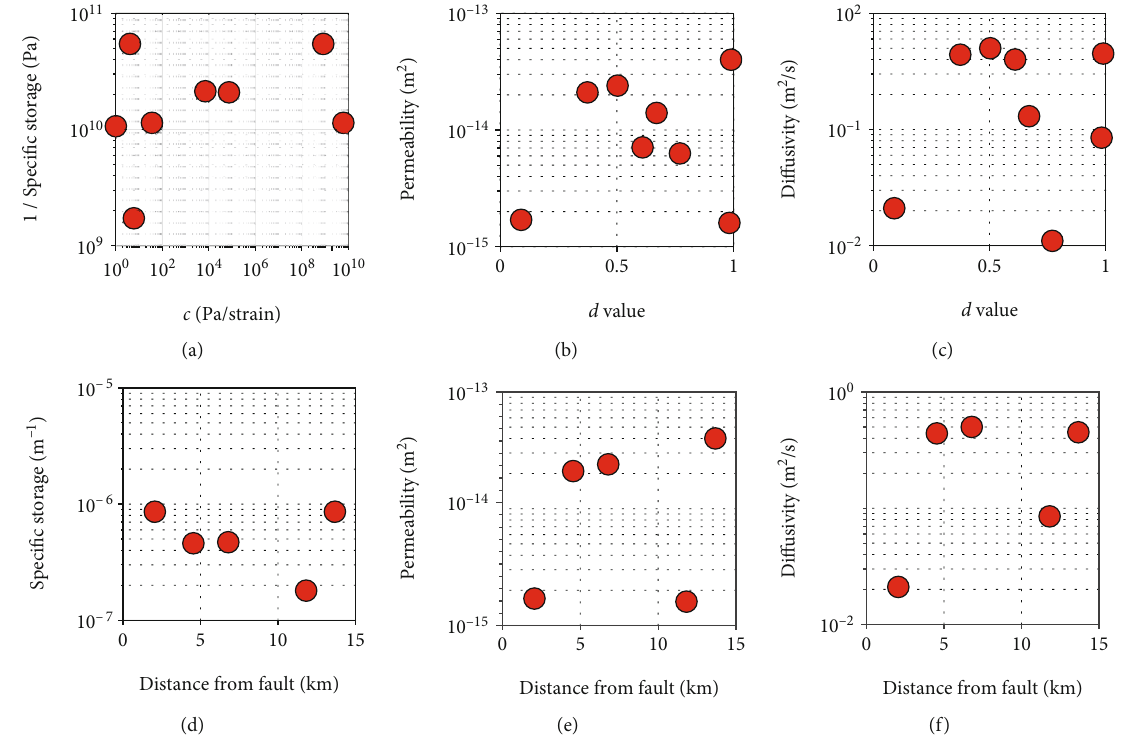
Figure 12: (a) Plot of c values from Barbour, 2015, versus obtained values of inverted speci fi c storage in terms of pressure. (b, c) Plot of d value from Barbour, 2015, versus obtained permeability and di ff usivity. (d — f) Distance from fault versus obtained hydrogeologic